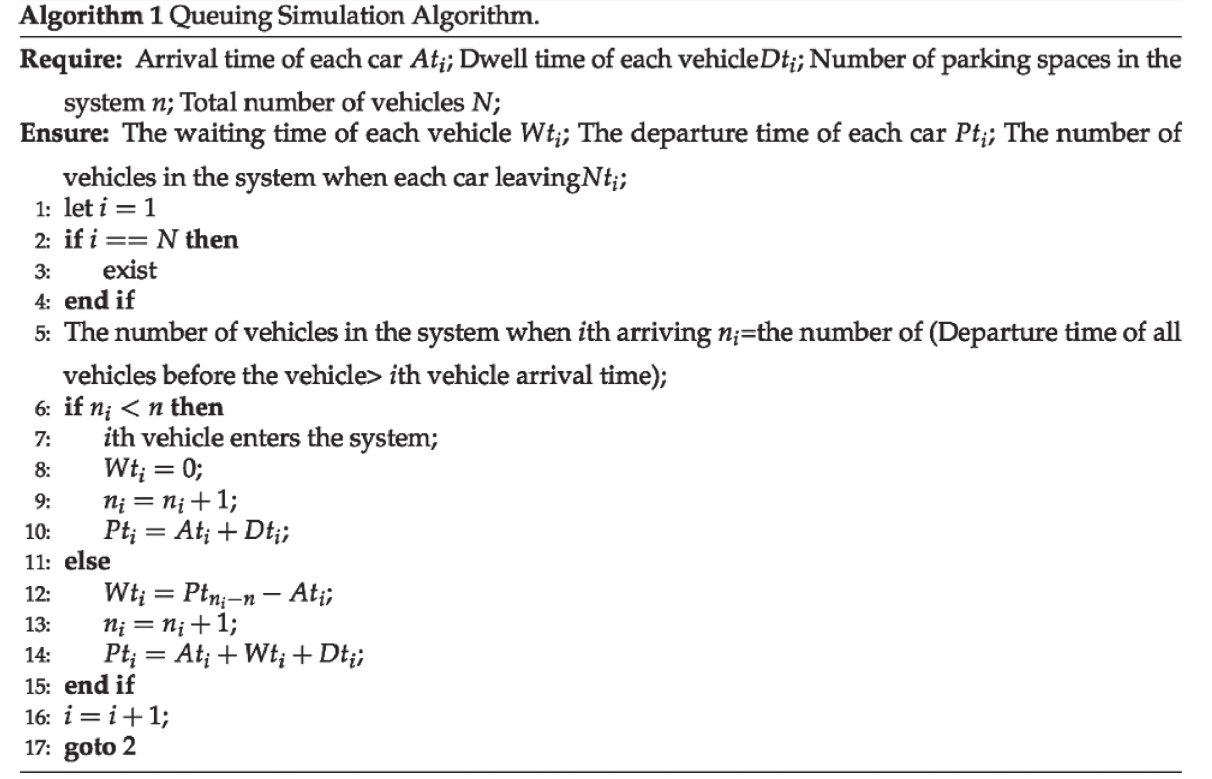
Figure 2: Code for queuing simulation